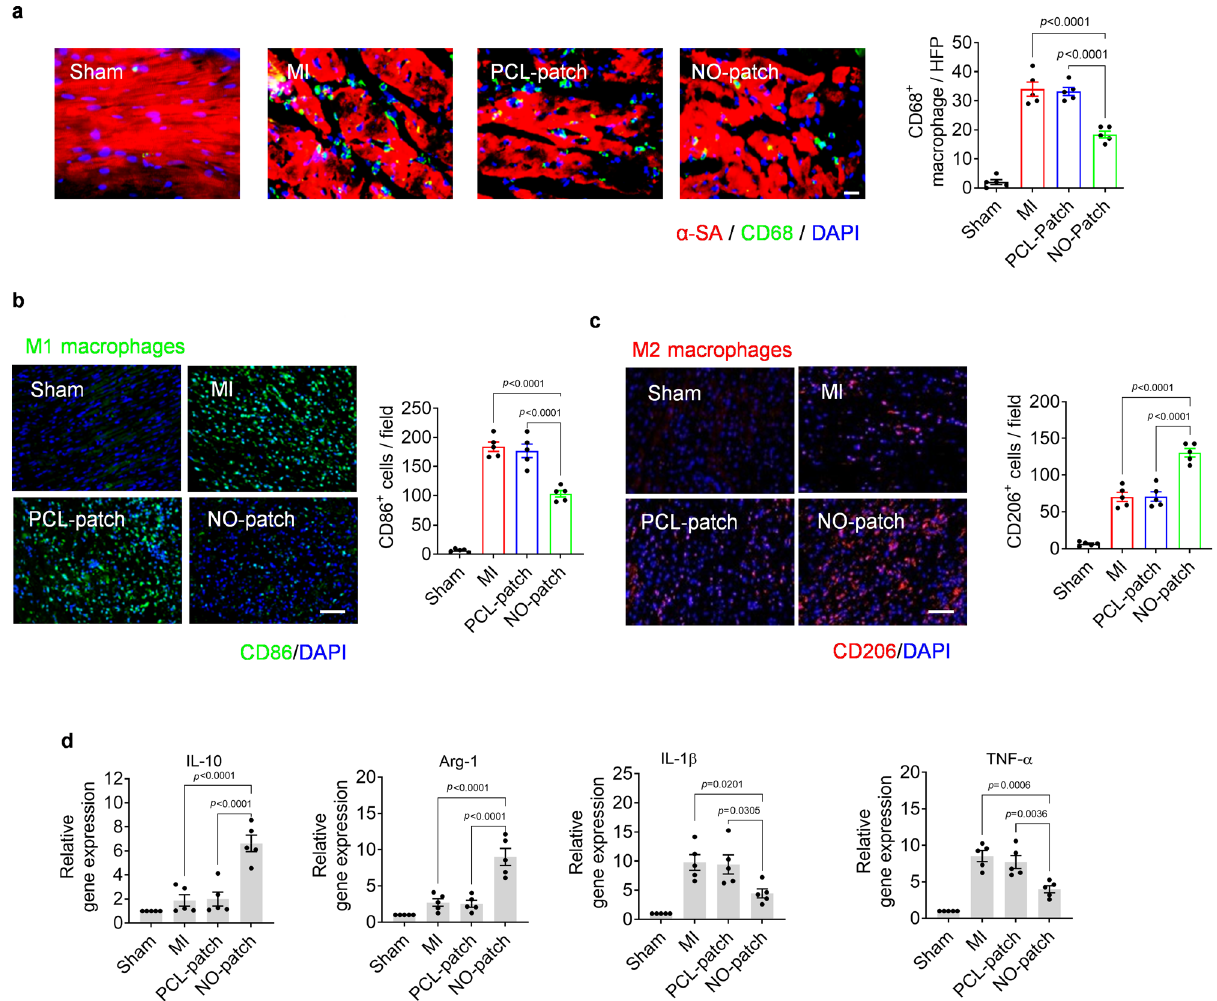
Fig. 5 Local NO delivery by nitrate-functionalized cardiac patches modulates macrophage polarization in infarcted heart of rats at early stage (day 3). a Representative images showing macrophage in fi ltration in infarcted heart by immunostaining with CD68 (scale bar, 40 μ m) as well as the corresponding quantitative analysis. b , c Macrophage polarization was further detected by immunostaining targeting CD86 and CD206, the maker of M1 and M2 phenotype, respectively (scale bar, 100 μ m). d The expression of pro-in fl ammatory and anti-in fl ammatory cytokines was evaluated by RT-PCR. Data are expressed as mean ± SEM, n = 5 animals per group. Signi fi cant differences were detected by two-tailed one-way ANOVA with Tukey ’ s